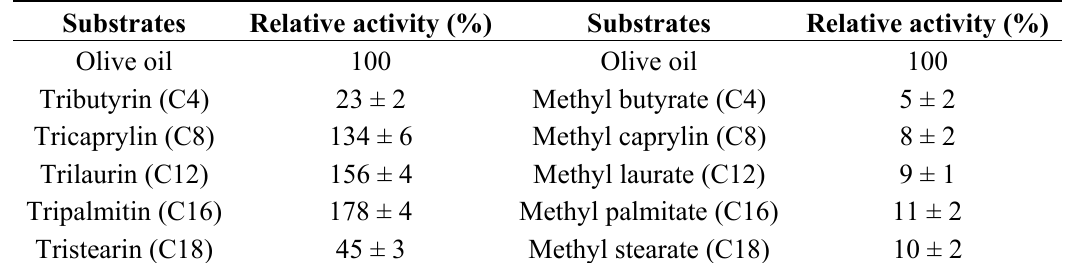
Table 5. Substrate specificity of rProROL on various triglycerides and fatty acid methyl esters. Activities on each substrate are expressed as the percentage of that on olive oil. All measurements were carried out in triplicate.